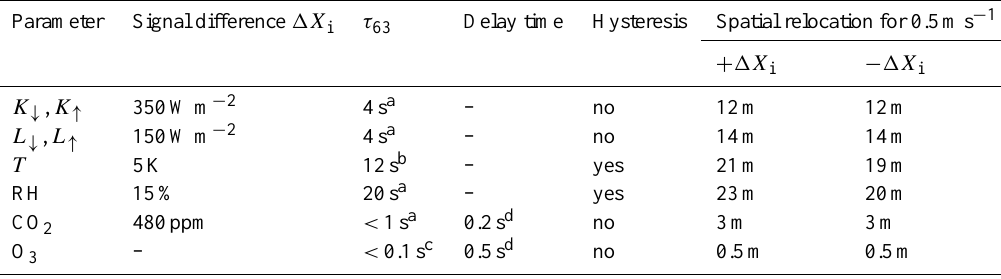
Table 3. Results of calculation of the sensor response time with the given signal differences 1X i in the laboratory test and its consequences on the location of the measured data. The spatial relocation is shown for a positive or negative signal difference, with the possible effect of hysteresis. For the sensors used see Table